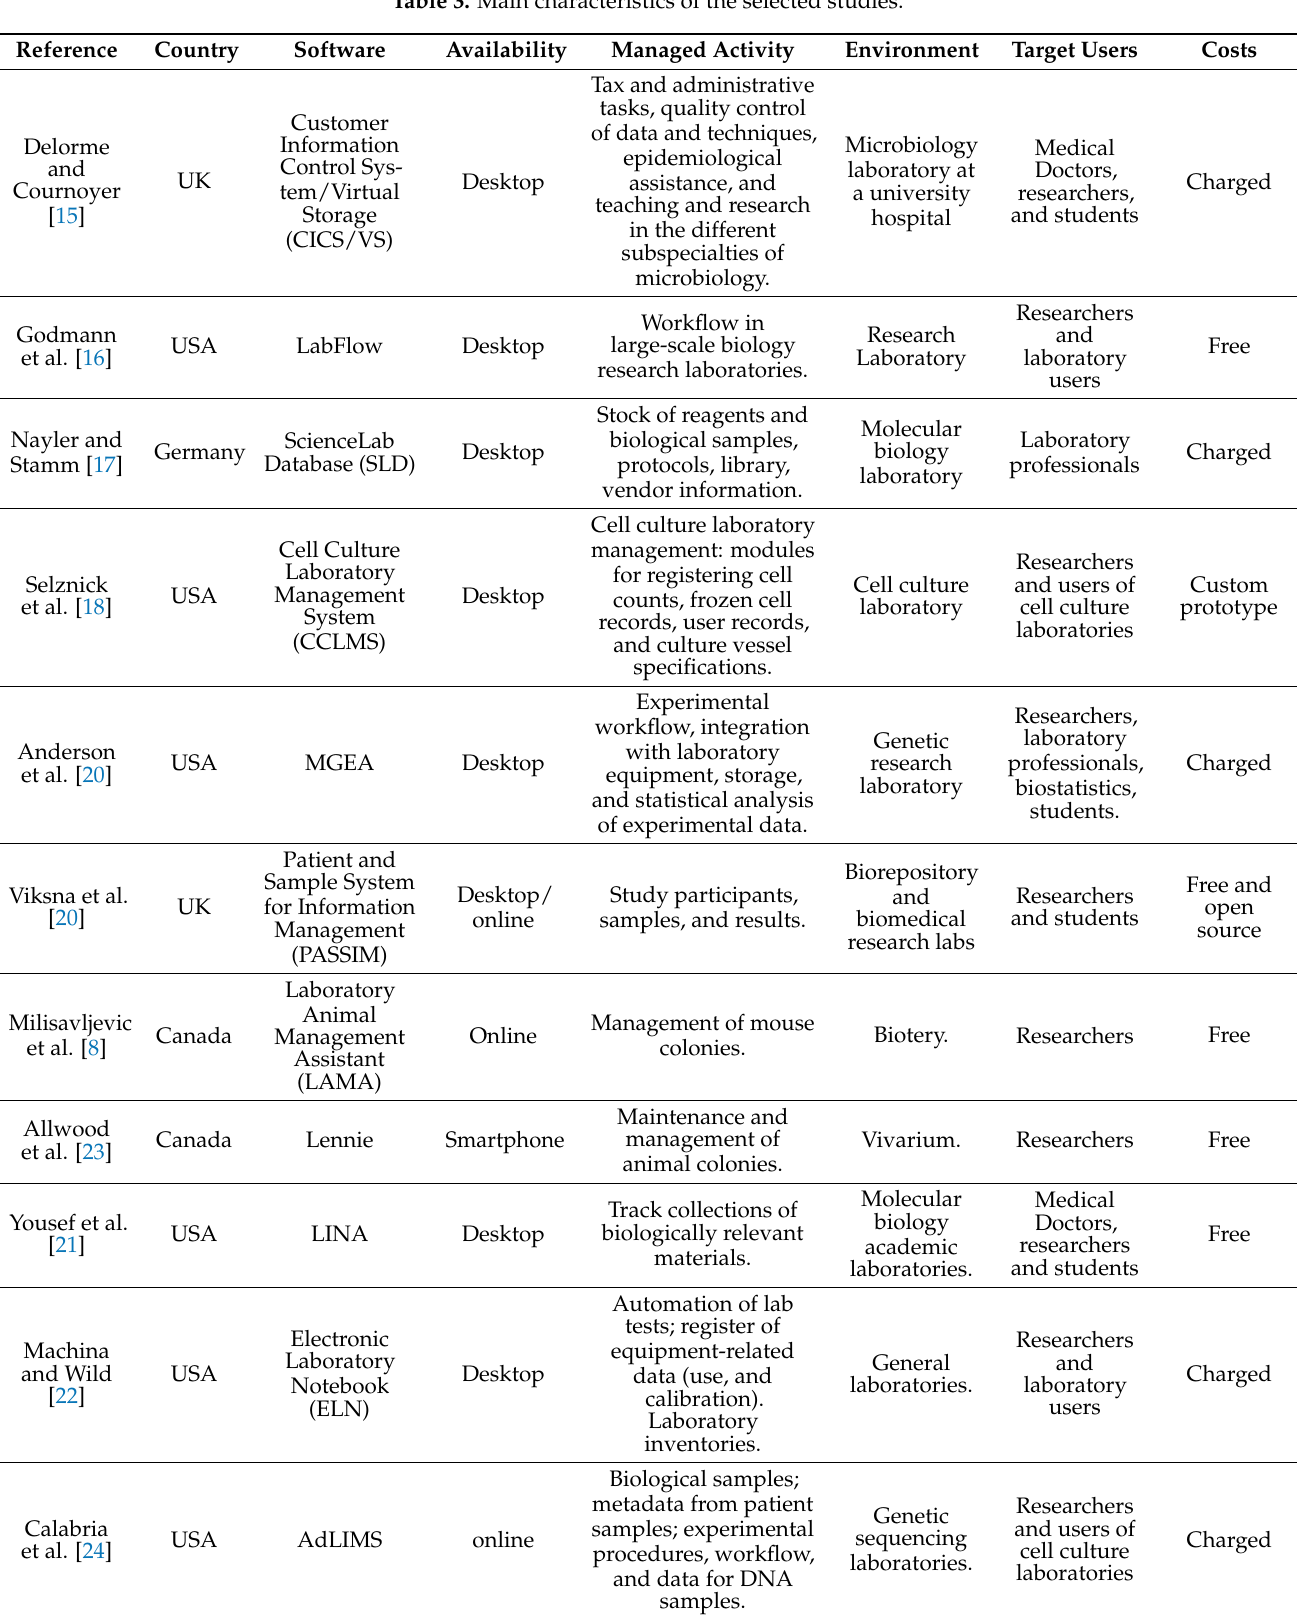
Table 3. Main characteristics of the selected